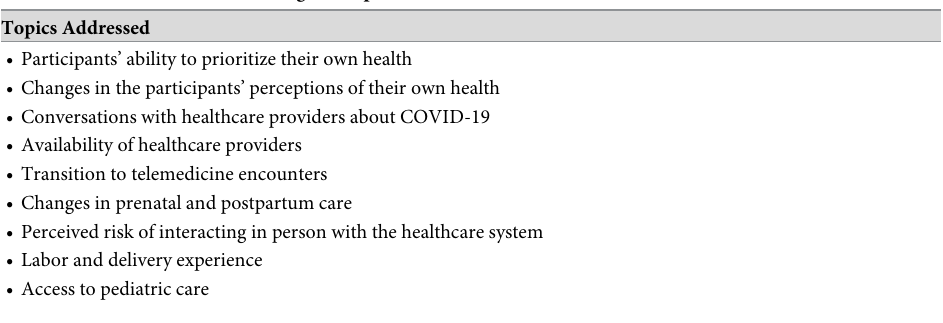
Table 1. Semi-structured interview guide topics. Topics